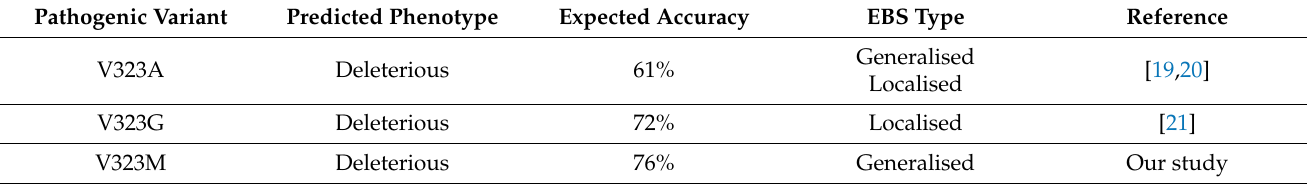
Table 1. PredictSNP analysis of pathogenic variants detected at the amino acid 323 of KRT5. Pathogenic